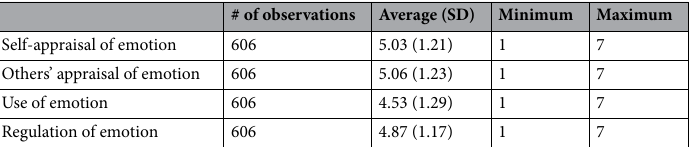
Table 1. Descriptive statistics of the collected sample of subjects from Reddit. Descriptive statistics of the Reddit sample.